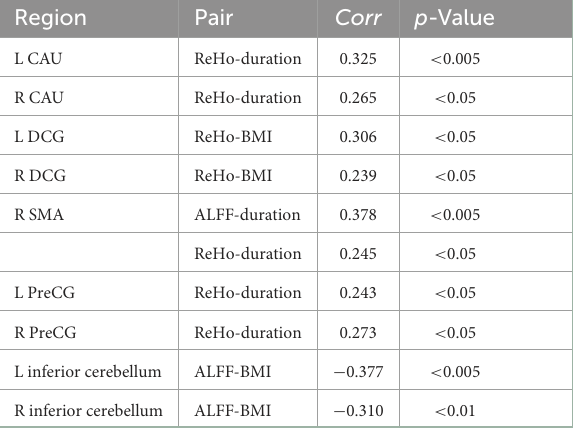
TABLE 4 Correlations between clinical parameters and the mean values of resting-state functional magnetic resonance imaging (rs-fMRI) indices extracted from significantly different brain